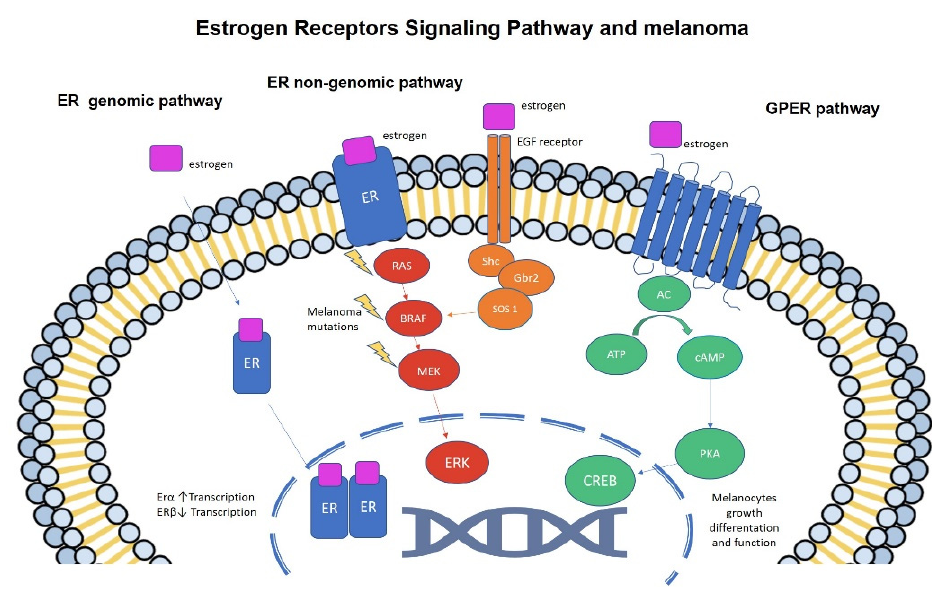
Figure 1. The main estrogen receptors signaling pathways: in the genomic pathway, classic estrogen receptors (ER α and β ) act as transcription factors upon homo- or heterodimers. ER α promotes DNA transcription, while ER β inhibits it. In the non-genomic pathway ERs act as membrane receptors and they lead to increased activity of the RAS / BRAF / MEK axis. Figure 1 demonstrates cross-talk with EGFR receptor pathway. The G protein-coupled estrogen receptor (GPER) acts via intracellular cAMP-protein kinase (PK) and cAMP-response element-binding protein (CREB) phosphorylation.